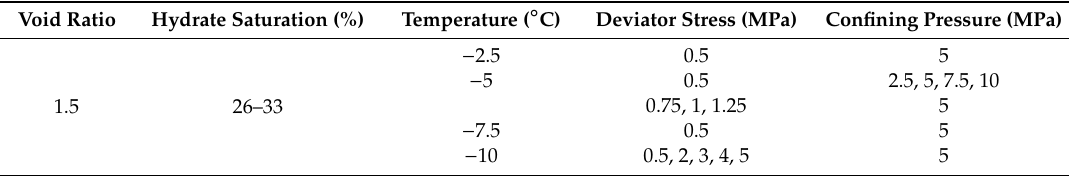
Table 1. Conditions of creep